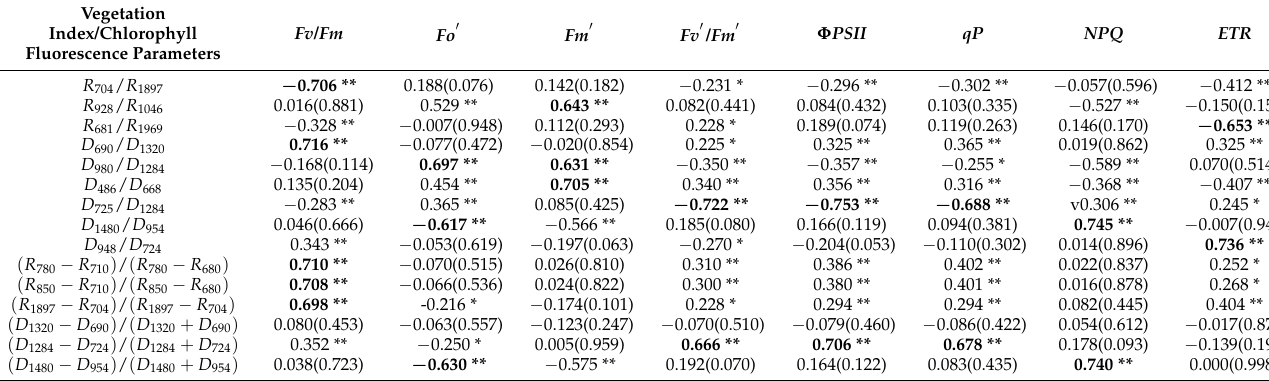
Table 2. Correlation analysis of hyperspectral vegetation index and chlorophyll fluorescence parameters under water and salt conditions. Vegetation Index/Chlorophyll Fluorescence